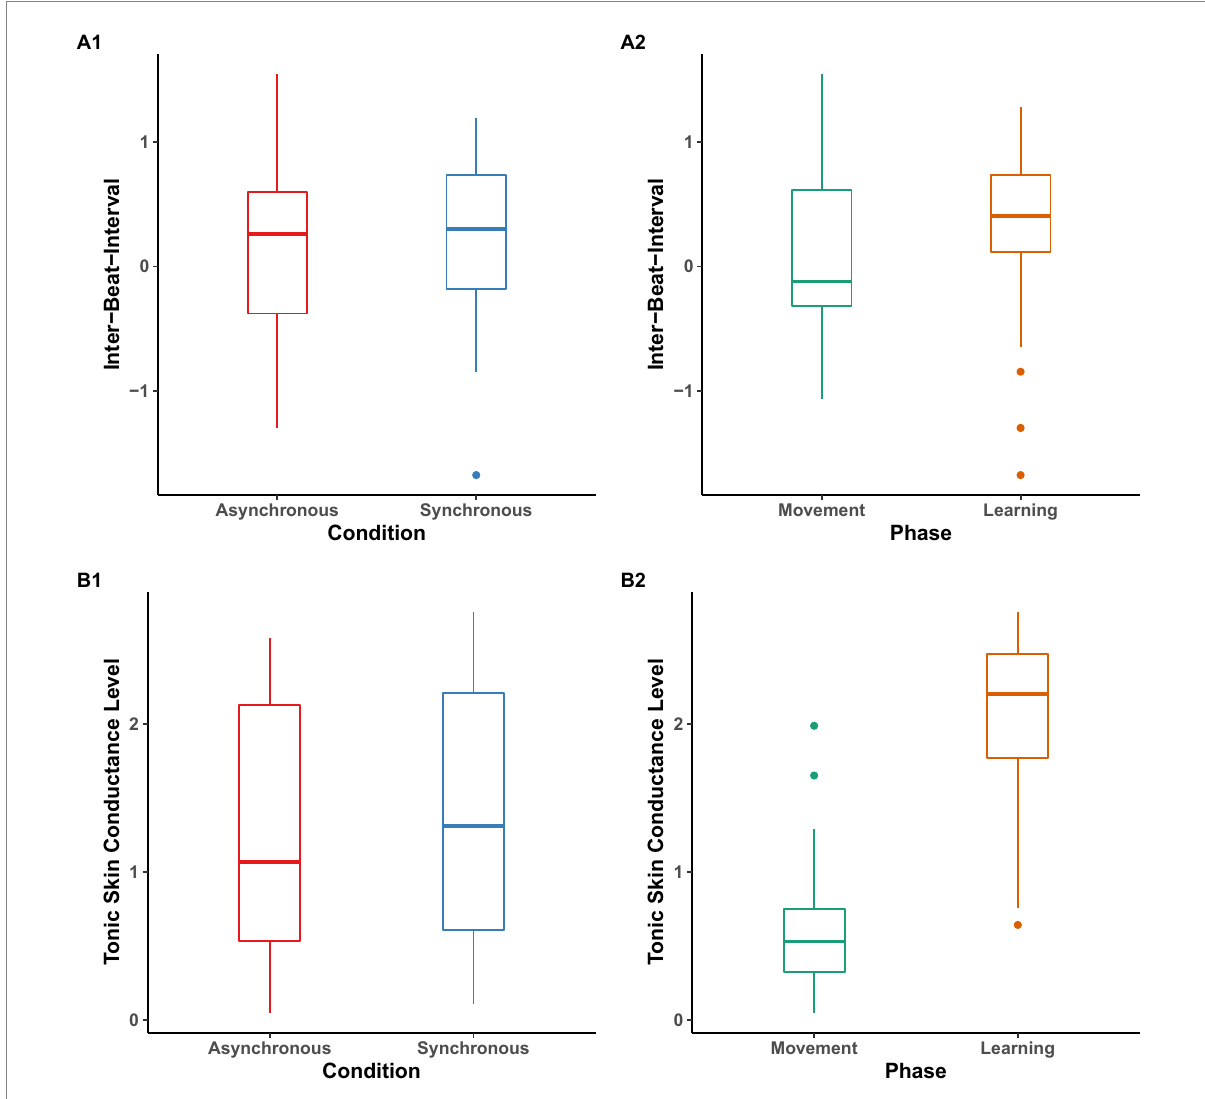
FIGURE 5 Inter-Beat-Interval (IBI) and Tonic Skin Conductance Level (SCL) baseline-corrected difference scores in z values across phases and conditions. Box plot of IBI (A1, A2) and SCL (B1, B2) across phases and conditions. The midline in the box represents the median values of each condition/ phase, outliers are shown as circles, and the error bars represent the 95%